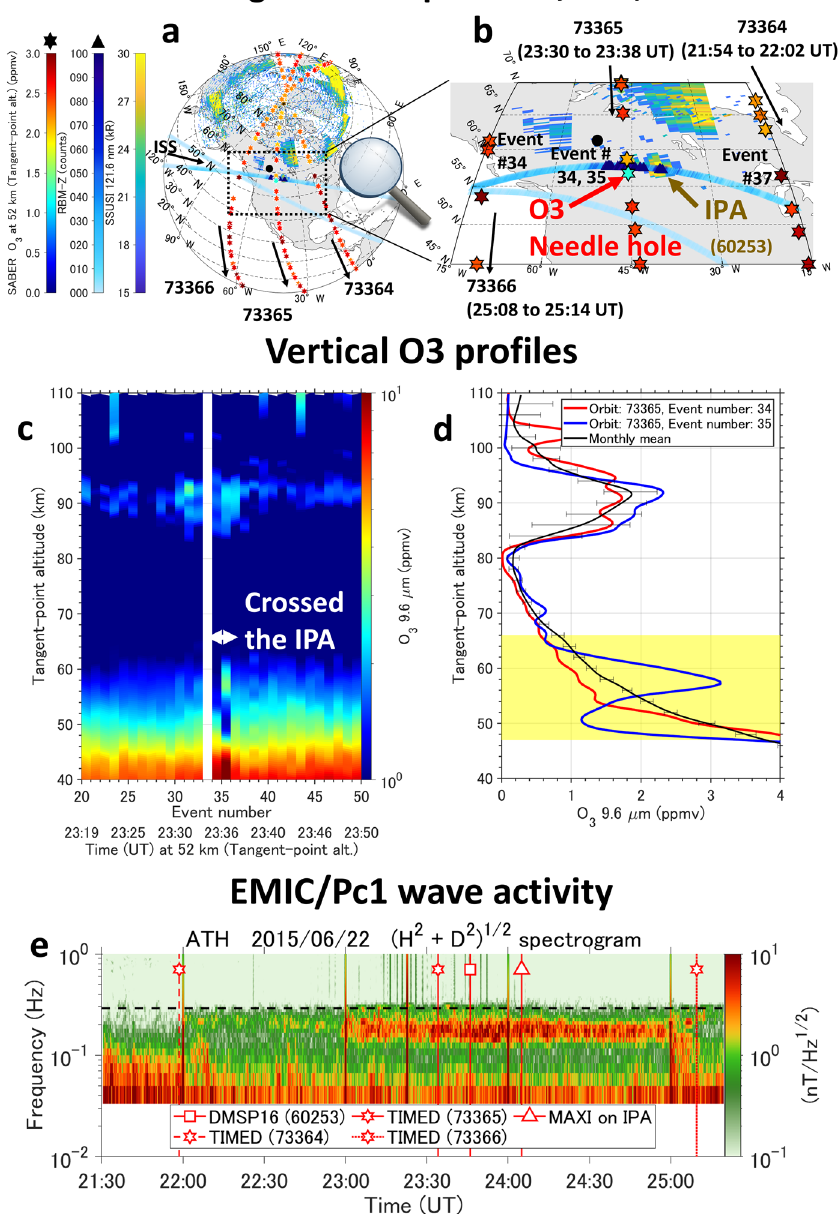
Figure 2. Localized ozone loss associated with the EMIC-driven IPA during a geomagnetic storm. ( a ) Global map of the mesospheric ozone (SABER, stars), REP (RMB-Z, triangles ≥ 90 counts), and aurora (superposition acquired from 19:44 to 25:46 UT by DMSP18 and 16/SSUSI). ( b ) Magnified map (aurora taken at 23:45 UT by DMSP16/SSUSI). Black arrows indicate the orbit direction of the ISS and TIMED satellite, with the orbit number and the time information in parentheses giving the measurement time for TIMED/SABER. The black dot indicates the location of Athabasca (ATH), Canada. Maps were generated by MATLAB R2020b, https:// www. mathw orks. com. ( c ) Tangent altitude profile of ozone during orbit 73,365 through the IPA. ( d ) Difference in the mesospheric ozone profiles. “Needle hole” region highlighted. ( e ) EMIC/Pc1 wave activity on June 22, 2015, at ATH. The black dotted line is the O + gyrofrequency at the magnetic equator estimated from an empirical geomagnetic field model 38 . Red lines indicate the time each instrument passed the magnetic latitude of the IPA (~ 57°). Numbers in parentheses denote the orbit number of each